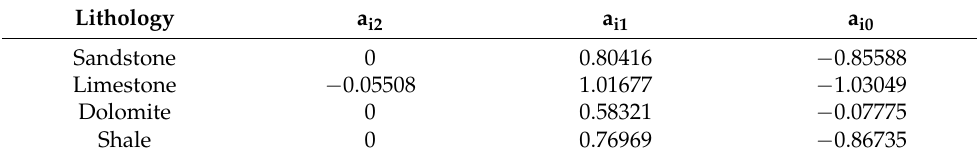
Table 1. Regression coefficients for V S prediction for the Greenberg—Castagna